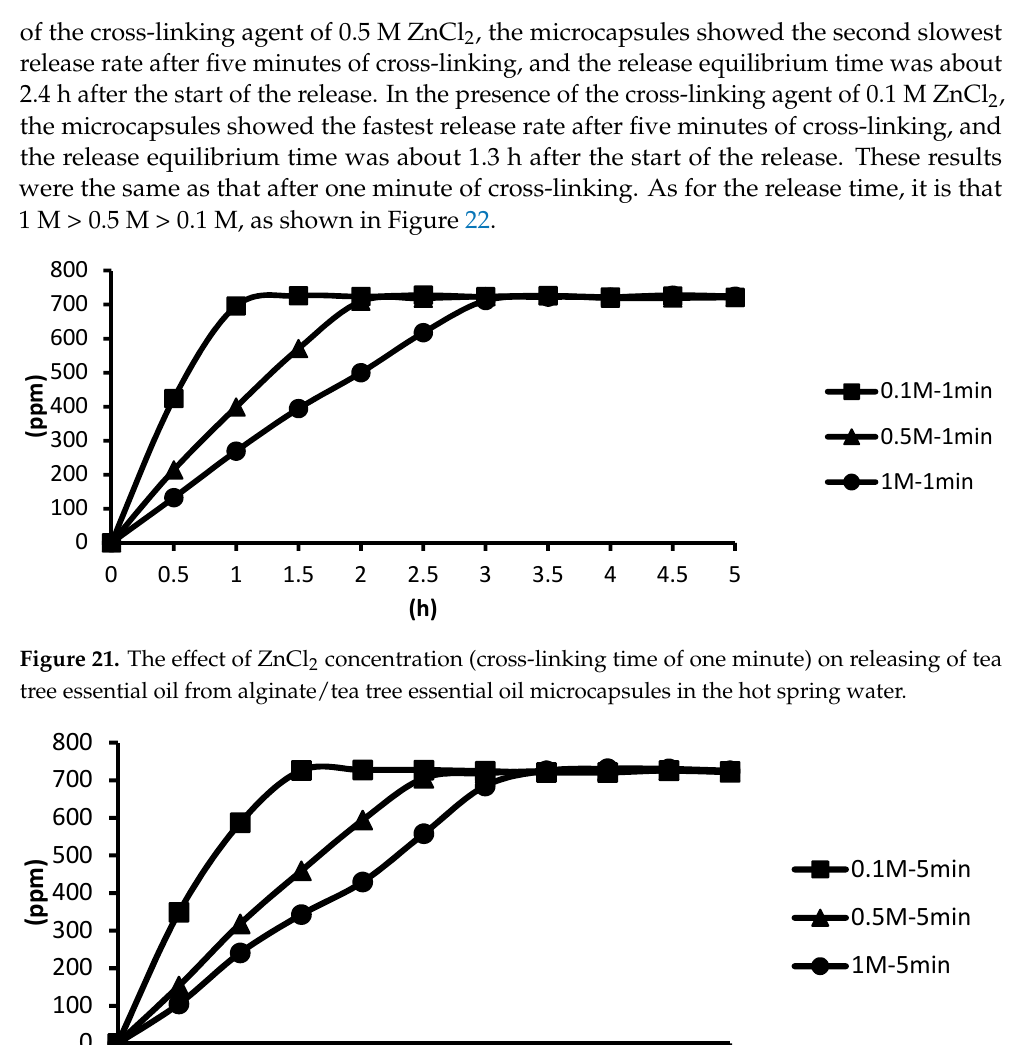
Figure 23. The effect of ZnCl 2 concentration (cross-linking time of ten minutes) on releasing of tea tree essential oil from alginate/tea tree essential oil microcapsules in the hot spring water. 4.4. Analysis of the Release of Microcapsules Obtained with Different Types of Cross-Linking Agents Release of microcapsules with different cross-linking agents of 0.1 M after the cross- linking time of one minute, five minutes, and ten minutes are shown as follows. Although the release curves of microcapsules obtained by the cross-linking agent of 0.1 M CaCl 2 and ZnCl 2 after the cross-linking time of one minute, five minutes, and ten minutes were very similar, it could still be seen that the obtained release rate of the microcapsules obtained by different cross-linking agents of 0.1 M had been affected after the cross-linking time of one minute, five minutes, and ten minutes. The release curves for the cross-linking time